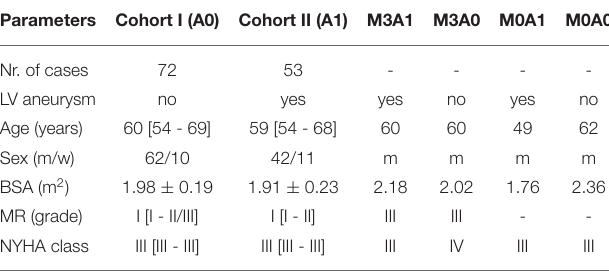
TABLE 1 | Clinical and demographic data of the two study cohorts and the four representative